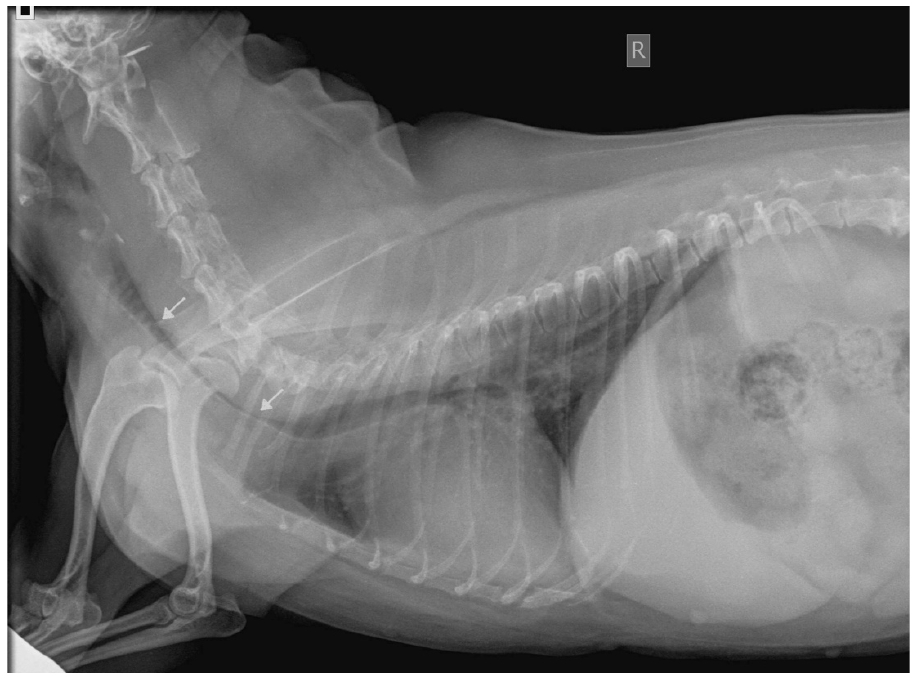
Figure 1. Laterolateral radiographic view of the neck and thorax of a dog with reverse sneezing showing a dorsoventral tracheal collapse that affects the cervical portion of the trachea up to the thoracic inlet (arrows).